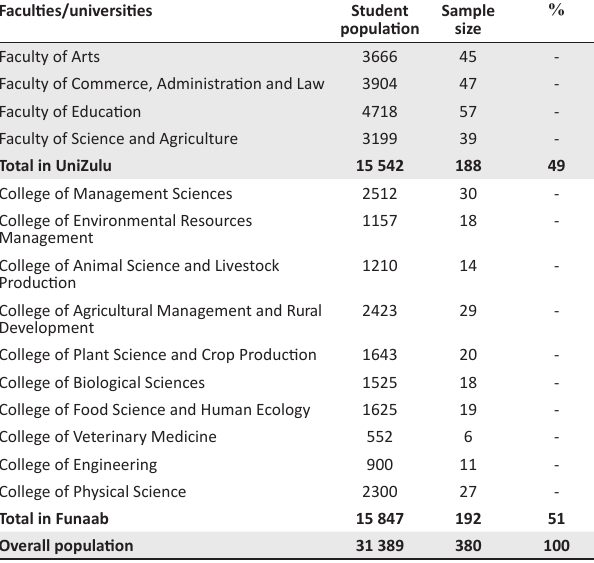
TABLE 1: Sampling frame for selection of